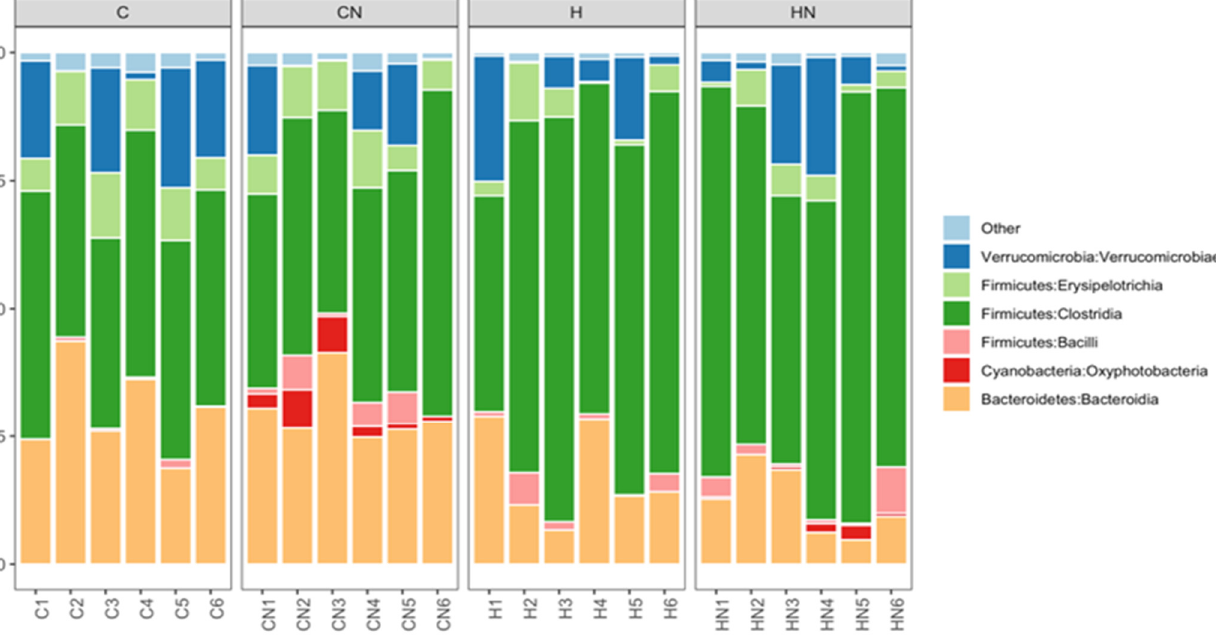
Figure 5. Taxonomic profiles of bacterial communities of all faecal samples shown at the class level. C, rats fed with corn starch diet; CN, rats fed with corn starch diet + Nannochloropsis oceanica ; H, rats fed with high-carbohydrate, high-fat diet; HN, rats fed with high-carbohydrate, high-fat diet + Nannochloropsis oceanica .